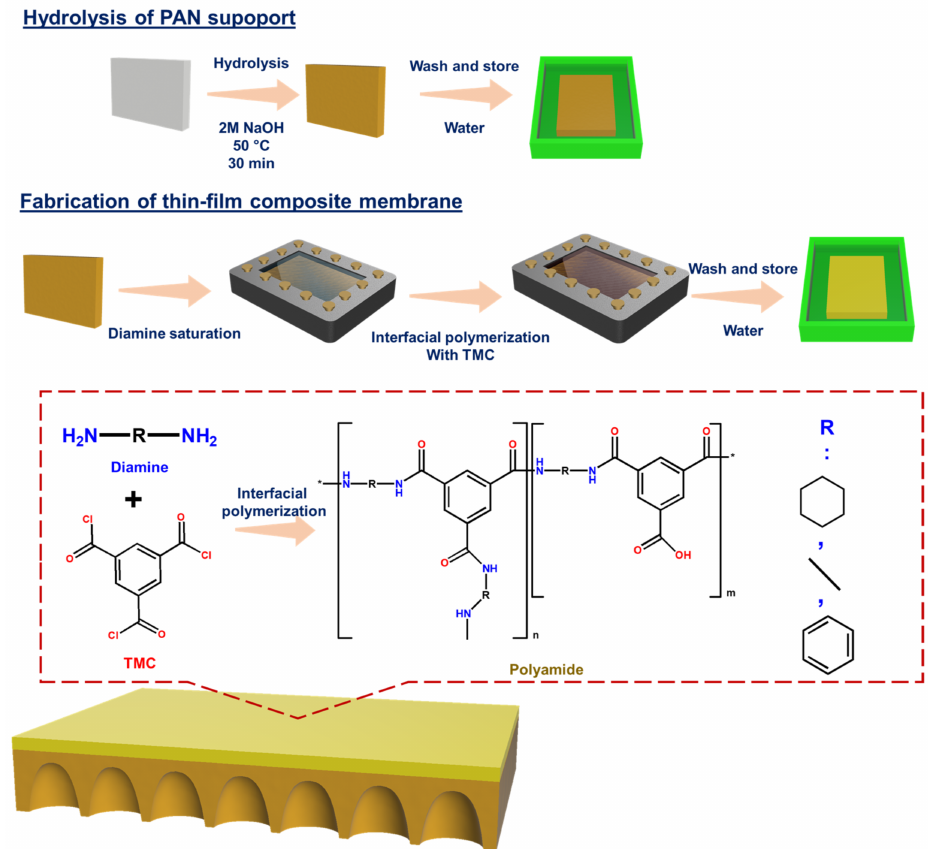
Figure 1. Schematic diagram of the membrane